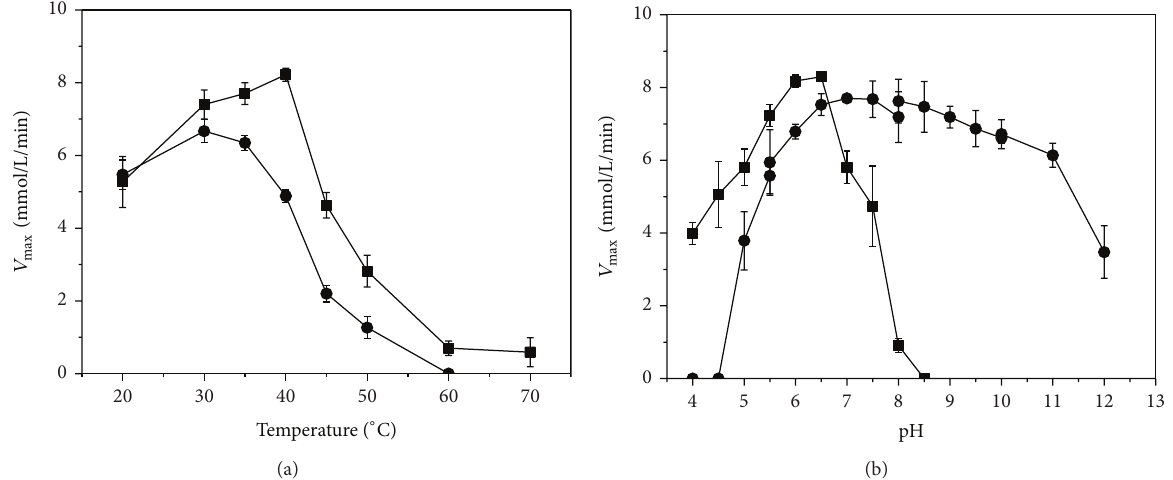
Figure 6: 𝑉 max determined from Lineweaver-Burk plot as a function of temperature (a) and pH (b) for the reaction of Microbacterium sp. XT11 xanthan lyase with xanthan as substrate. The temperature/pH optimum was symbolized as “ ◼ ” and the thermostability/pH stability was marked as “ e